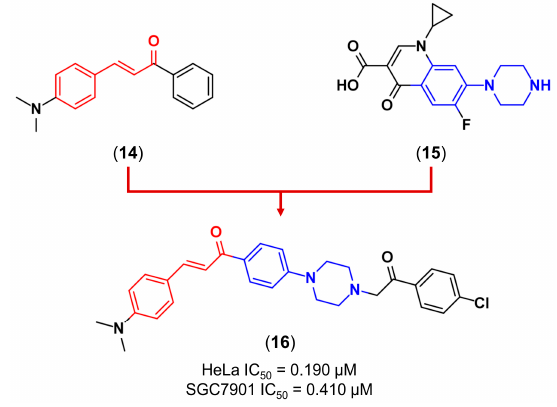
Figure 6. Molecular hybrid obtained from the combination of chalcones (red) and N -aryl piperazine moiety (blue) [50].